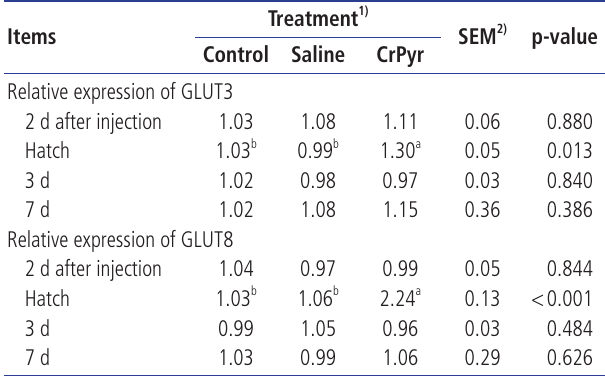
Table 8. Effects of in ovo feeding of creatine pyruvate on the mRNA expressions of GLUT3, GLUT8 in thigh muscle of embryos and broilers on 2 d after injection, the day of hatch, 3, and 7 d post-hatch